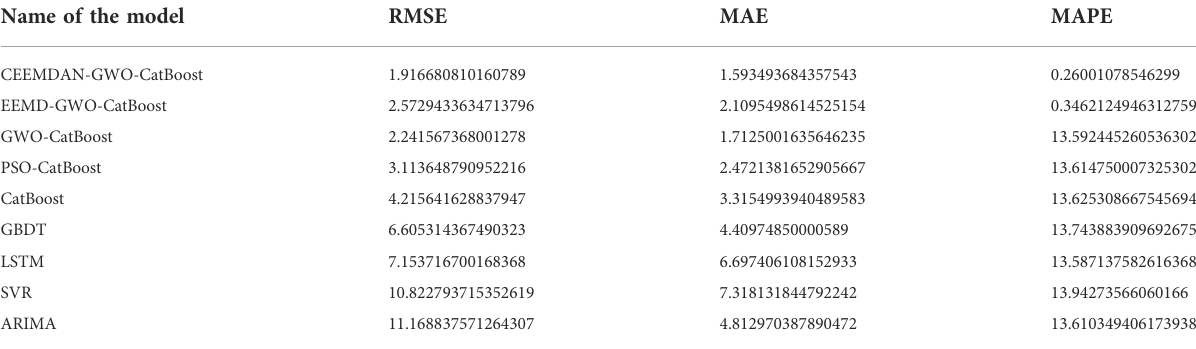
TABLE 5 Model prediction accuracy table for coal price